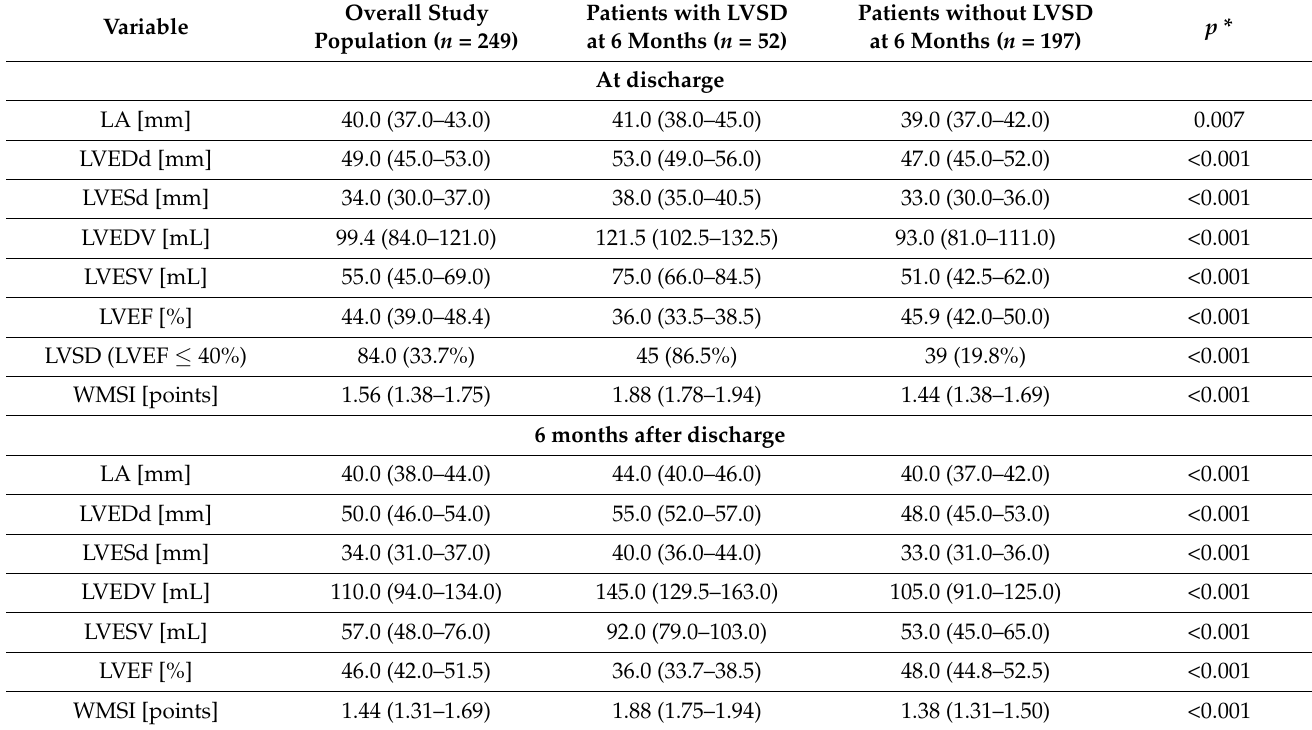
Table 2. Echocardiographic characteristics of the study population in relation to LVSD occurrence. Data are presented as median (lower quartile-upper quartile).